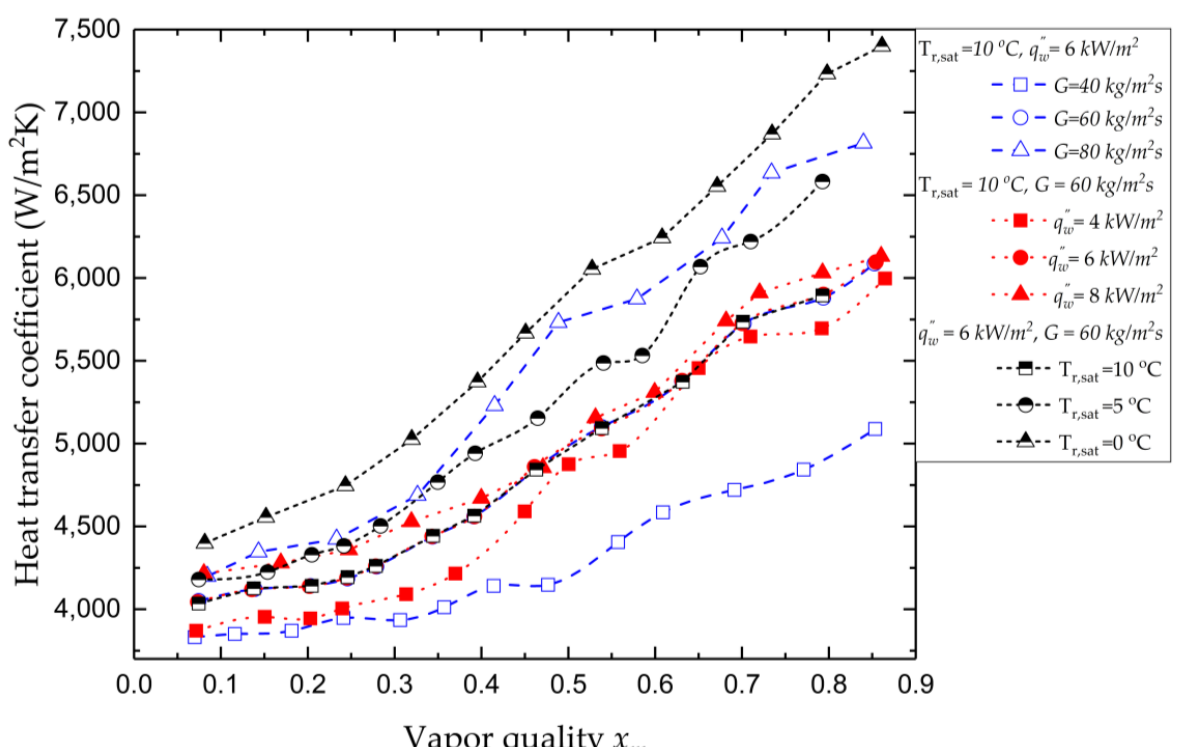
Figure 20. Variations in two-phase frictional pressure drop for R-1234ze(E) as measured in the PHE [15].